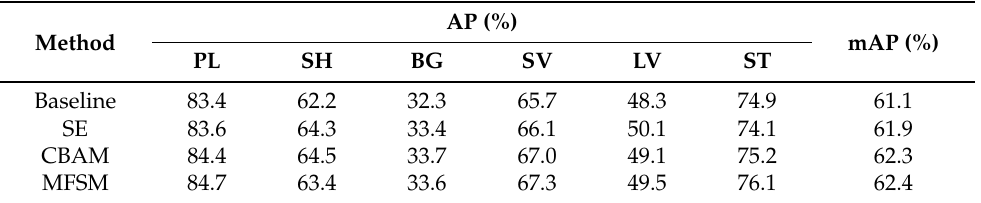
Table 2. Experimental results of different attention